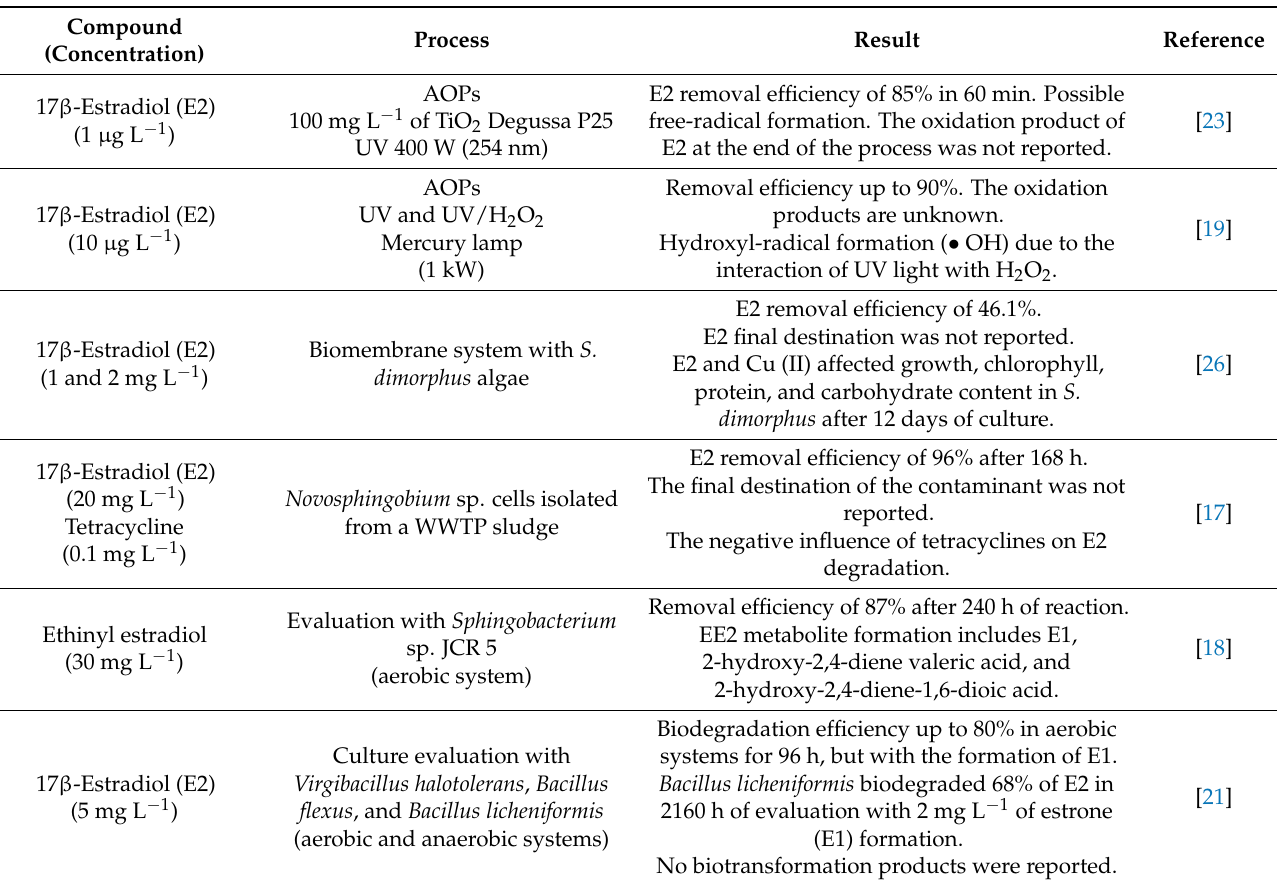
Table 1. Processes for the treatment of water containing 17 β